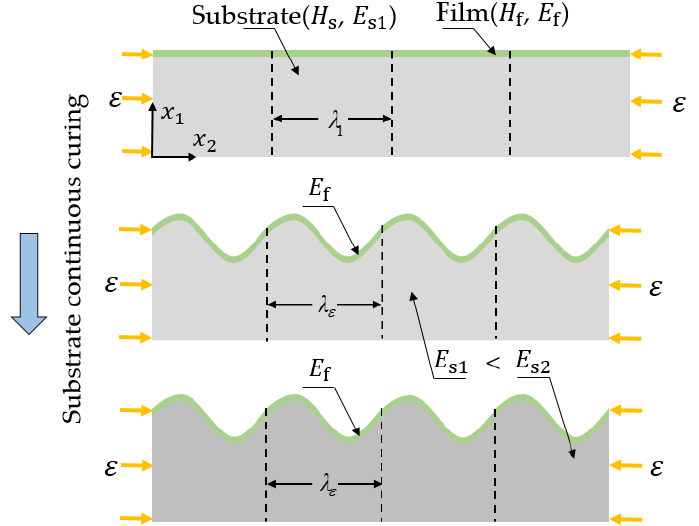
Figure 1. Schematic diagram of moisture-curing process.